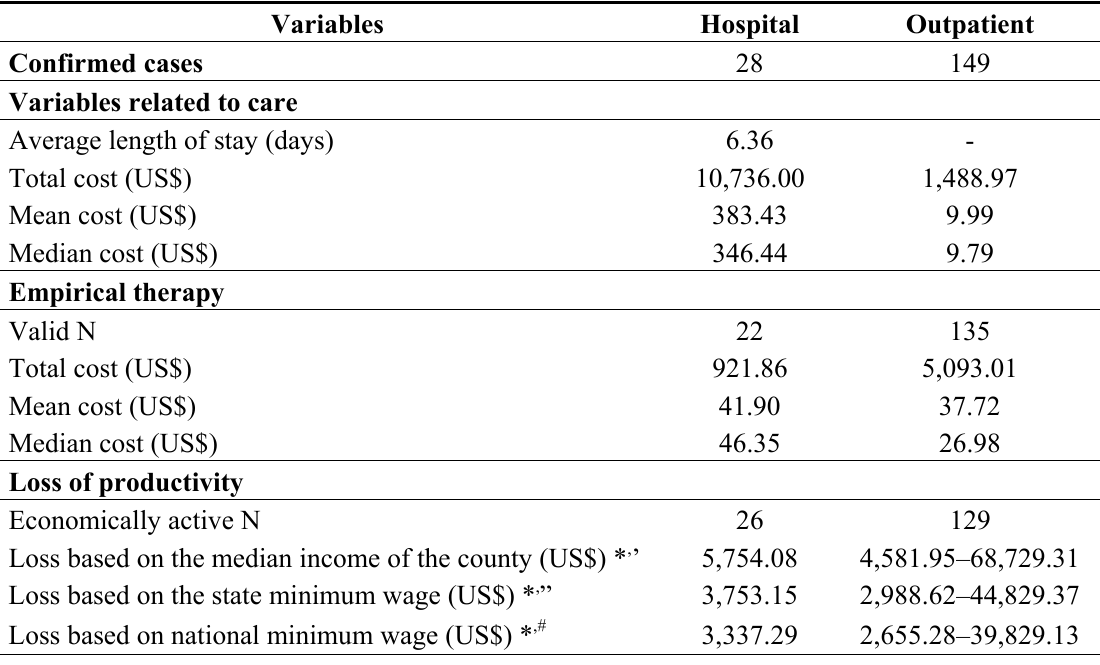
Table 4. Summary of costs associated with confirmed leptospirosis cases attributed to the 2011 disaster in Nova